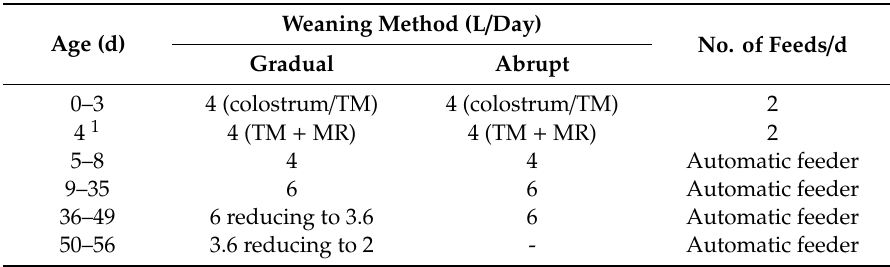
Table 1. Colostrum / transition milk (TM) and milk replacer (MR) feeding plan for calves allocated to either a gradual or abrupt weaning